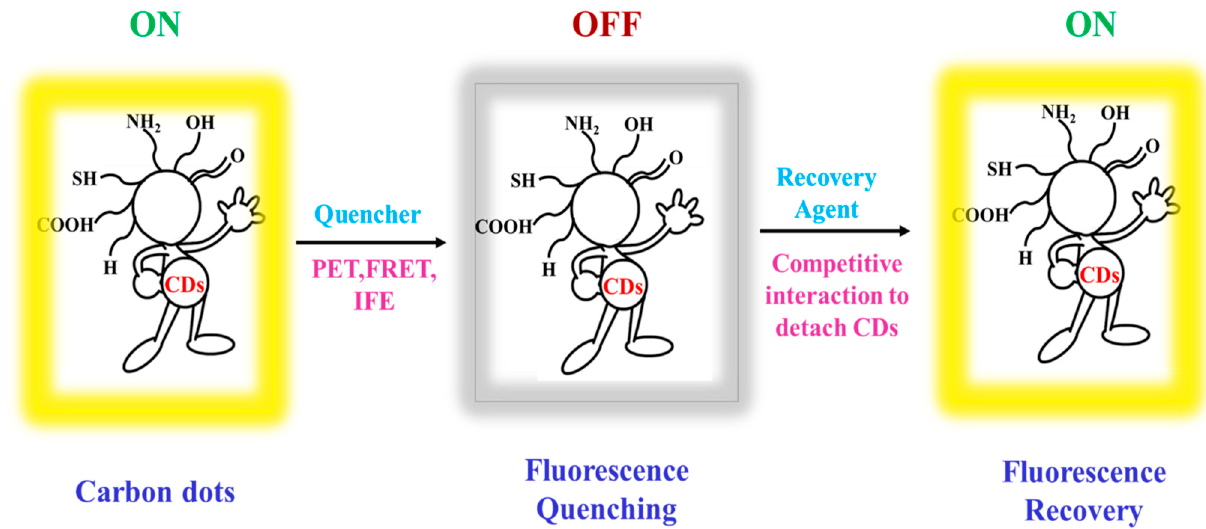
Figure 3. Mechanism of sensing CDs based logic systems with photoinduced electron transfer (PET), fluorescence resonance energy transfer (FRET), and inner filter effect (IFE) process for quenching and recovery by interactions with recovery agents.